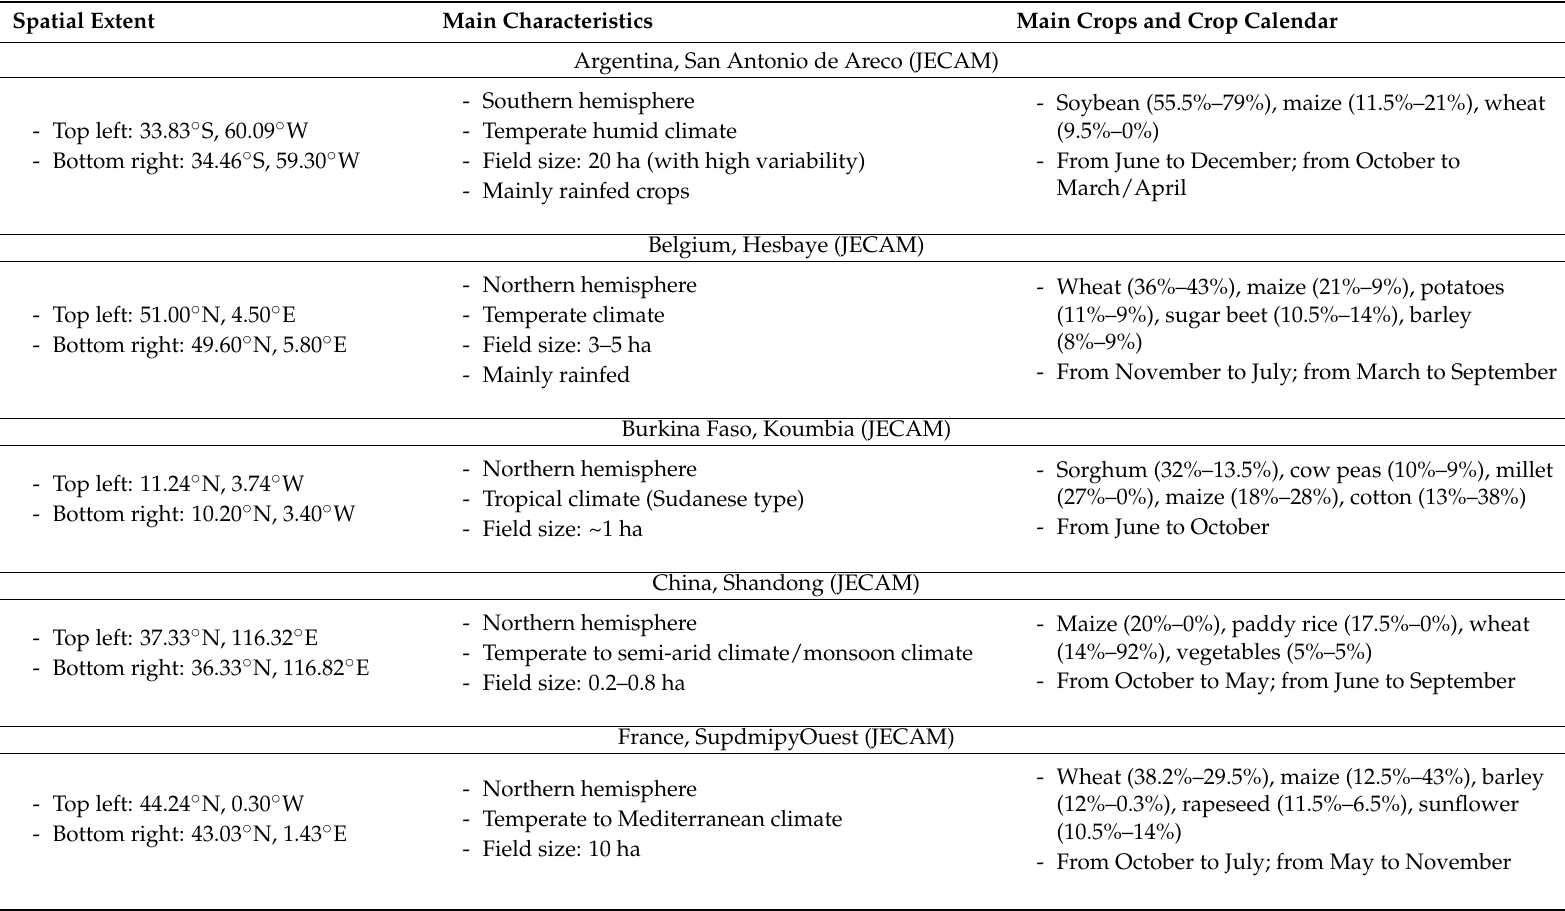
Table 3. Site descriptions. In the crop description, figures in parentheses indicate the crop percentages according to FAO national statistics (first figure) and site statistics (second